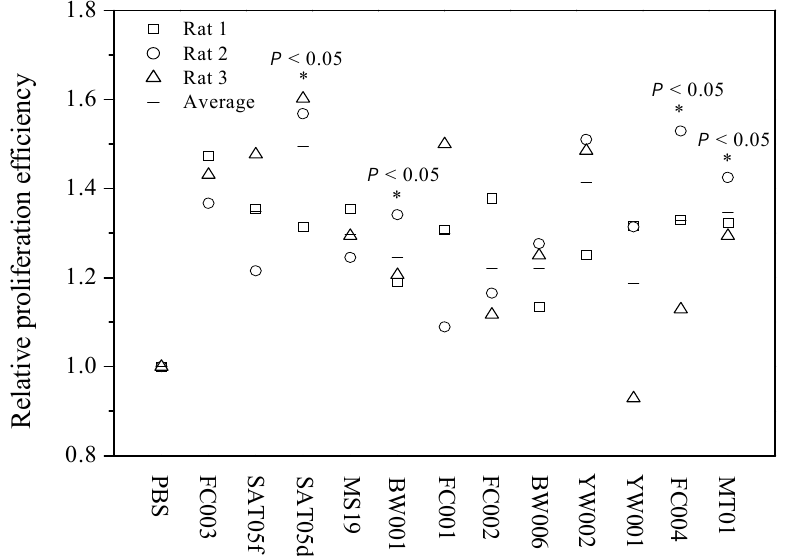
Figure 2. Effect of ODNs with different sequences on the expression of alkaline phosphatase (ALP) in rat BMSCs. ( A ) Screen of the ODNs ( n = 6 per group); ( B ) Dose effect of the ODNs ( n = 6 per group); ( C ) Kinetic effect of the ODNs. * Indicates statistically significant difference ( P < 0.05) between MT01 and PBS; ** Indicates statistically significant difference ( P < 0.01) between MT01 and